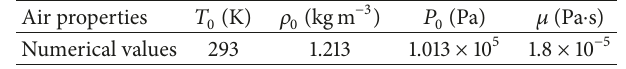
Table 1: The physical parameters of air used in this paper.